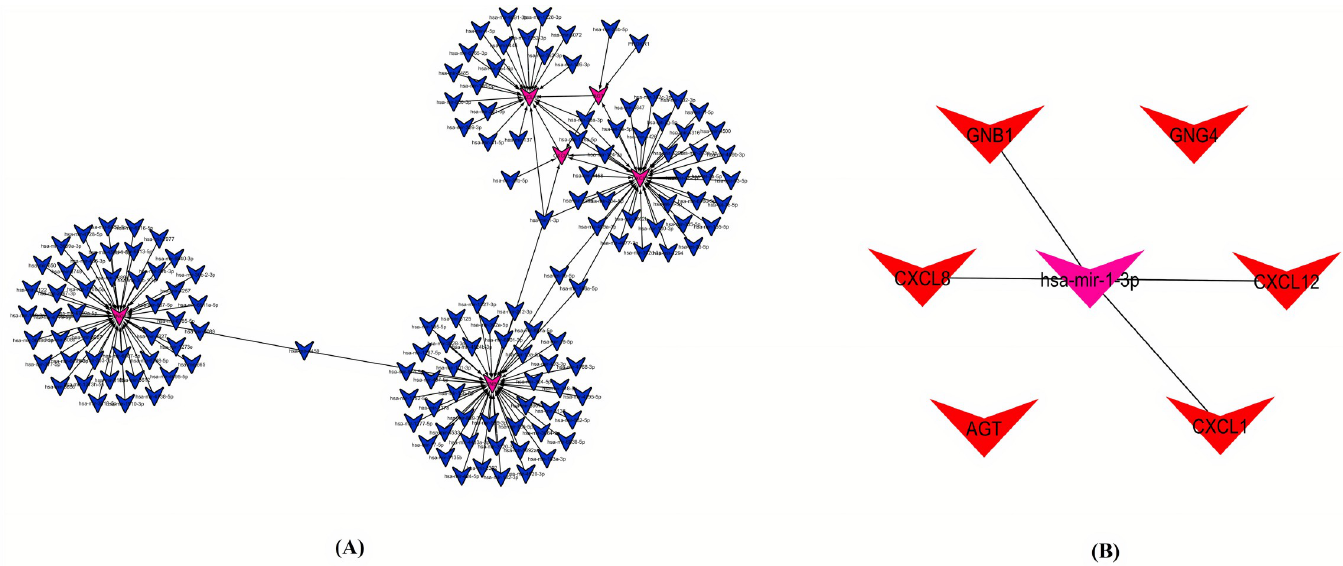
Fig 15. The miRNA–real hub gene interaction network. The pink circular node represents the miRNA. The blue v shape node represents the hub gene while pink and red v shape node represents the mir-1-3p/CXCL8 or CXCL12, CXCL1, and GNB1 axis. The arrow shape represents the interaction between the miRNAs and real hub genes.